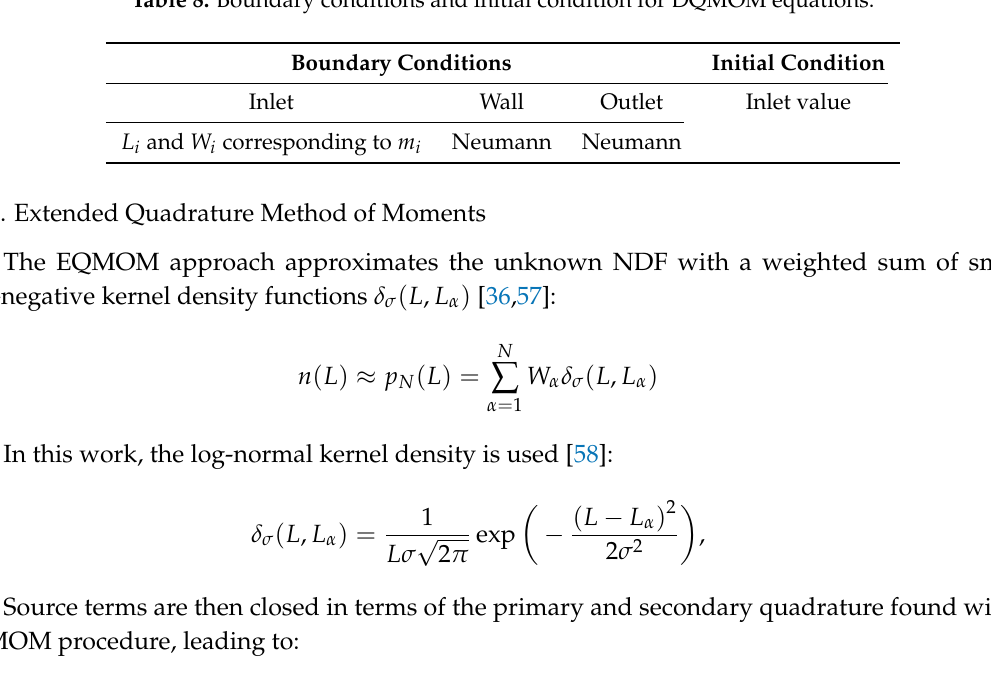
Table 8. Boundary conditions and initial condition for DQMOM